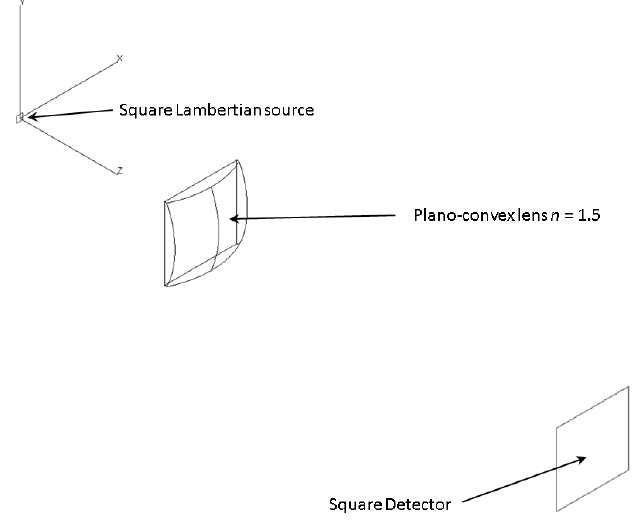
Figure 5. Sketch of the 3D source-lens-detector analyzed system.